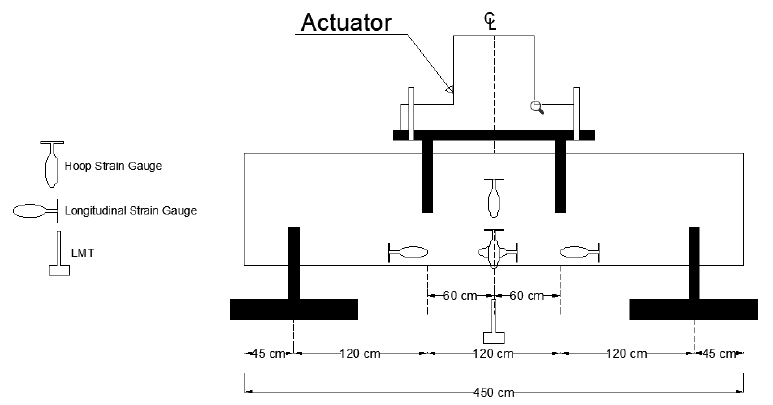
Figure 2. Instrumentation and beam test setup.